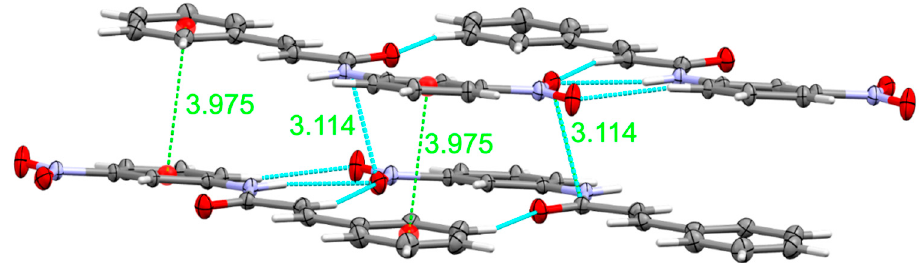
Figure 4. Basic π -stacking interactions. Shown are the shortest centroid-to-centroid distances (centroids are shown as red spheres) between phenyl and nitrophenyl rings, and the shortest atom to atom π -stacking interaction between C-amide and O-nitro atoms. Distances in Å.